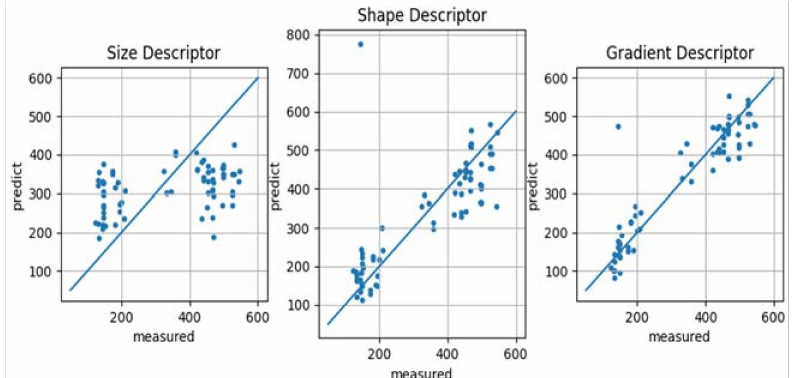
Figure 15. Scatter plot for the actual value and predicted value using three kinds of descriptors.